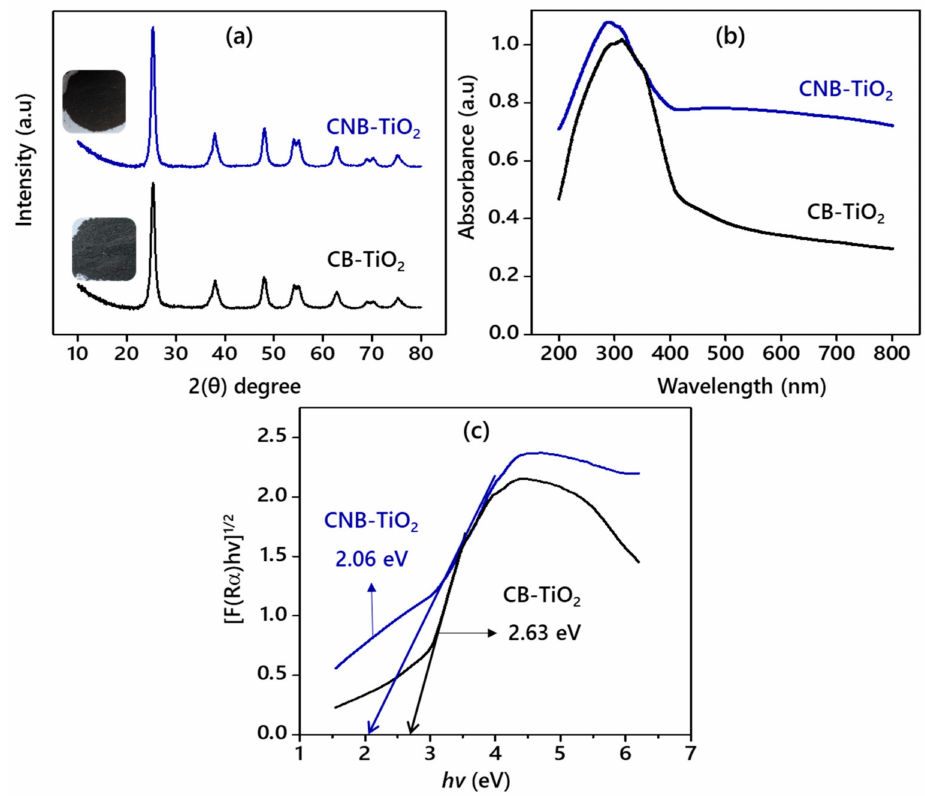
Figure 3. ( a ) XRD patterns, ( b ) UV-vis absorption spectra, and ( c ) T-plot of the bandgap energies of the CB-TiO 2 and CNB-TiO 2 . Inset of ( a ) photographs of the CB-TiO 2 and CNB-TiO 2